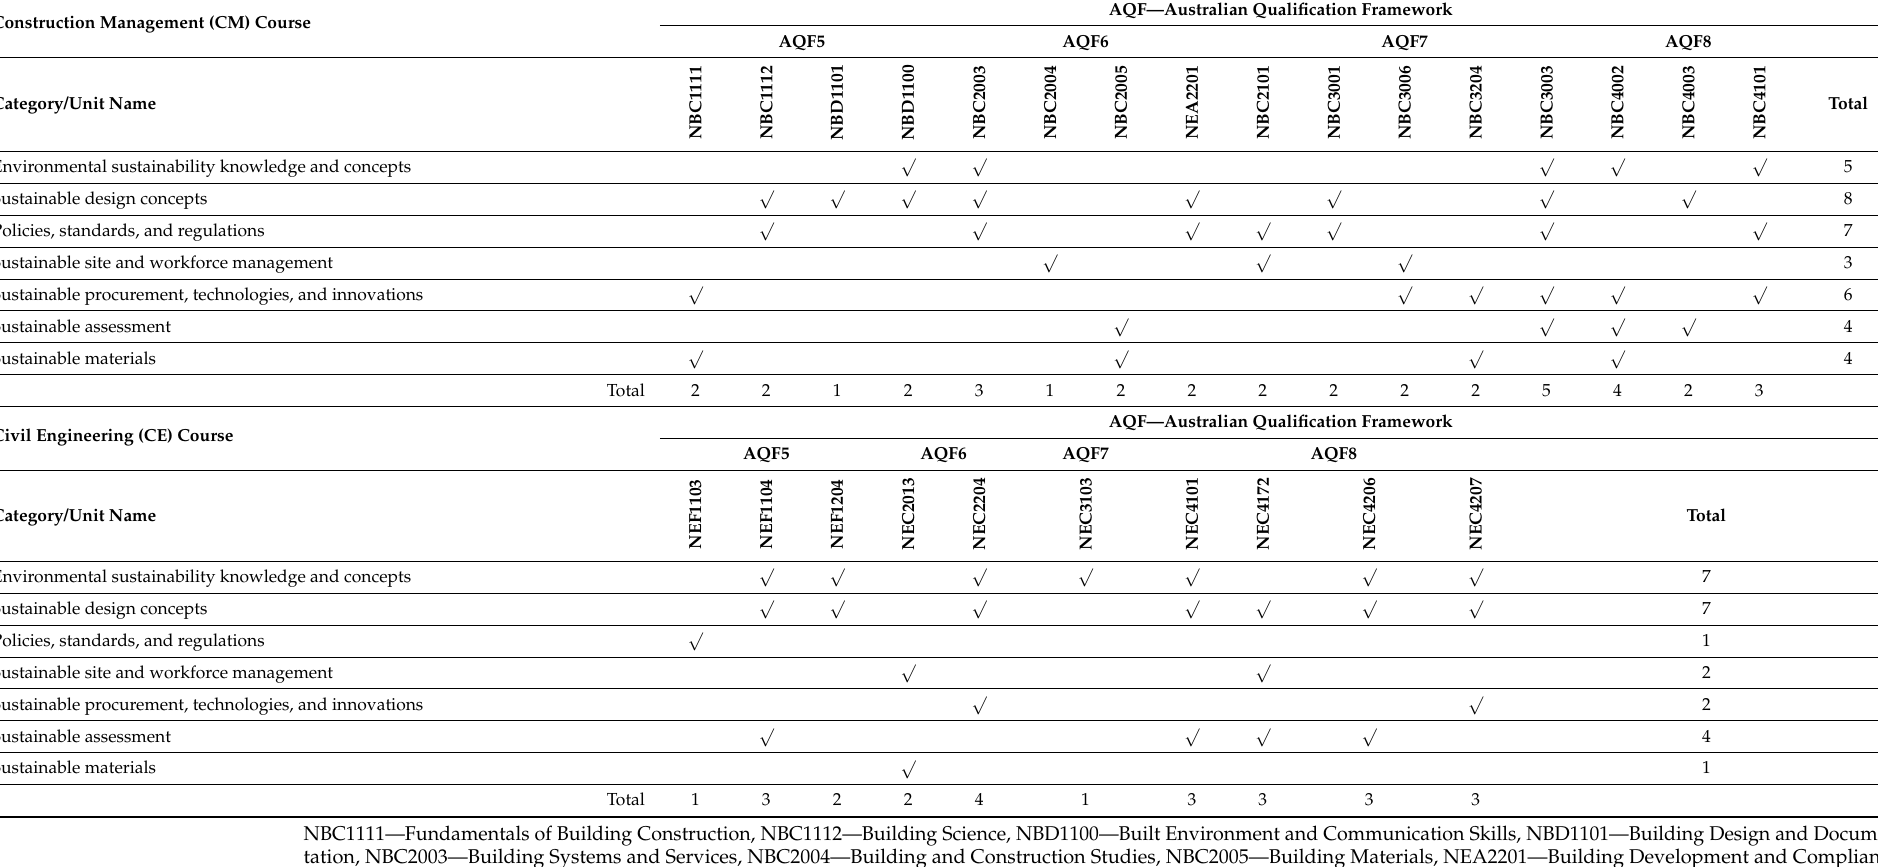
Table 5. Environmental sustainability aspects in each unit of CM and CE courses at different AQF